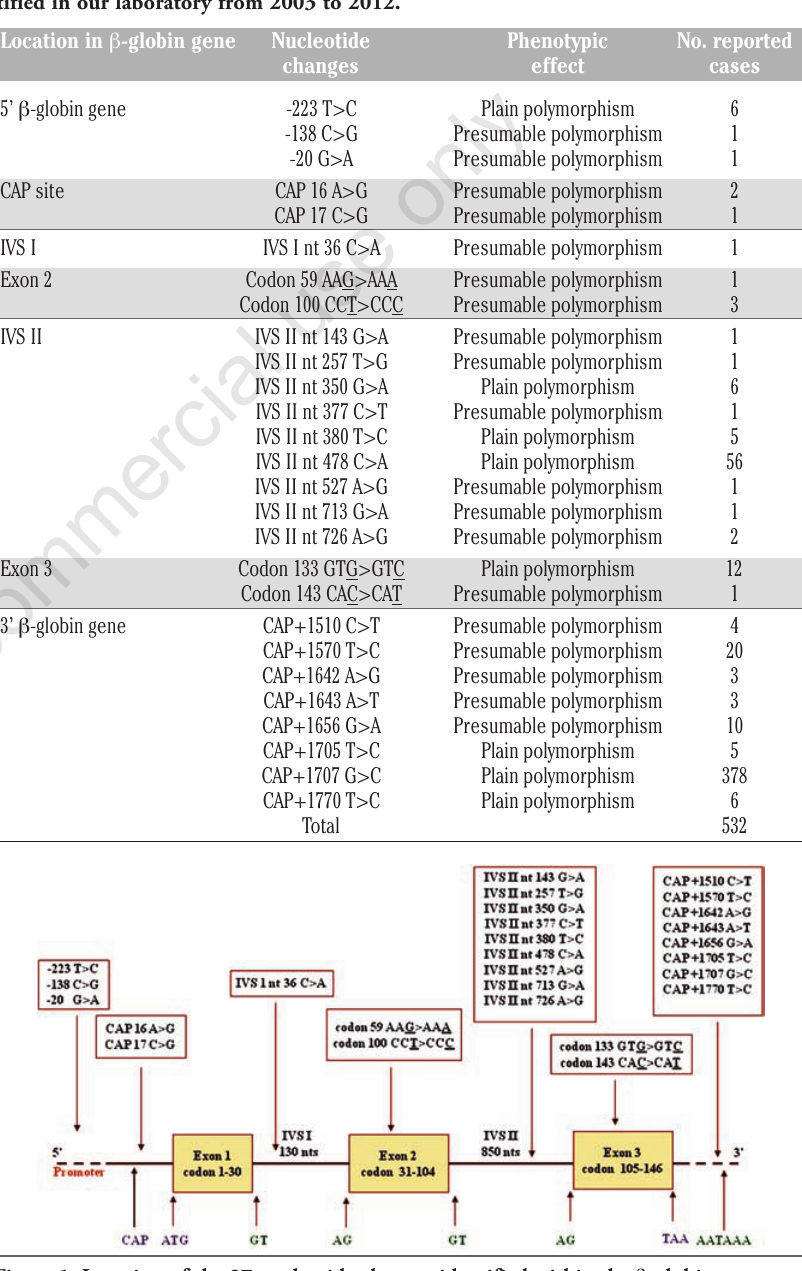
Figure 1. Location of the 27 nucleotide changes identified within the β -globin